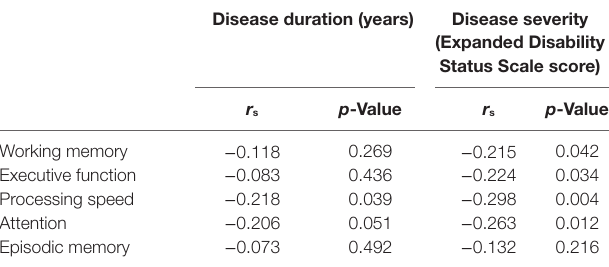
TaBle 2 | Correlations between disease duration, severity, and cognitive